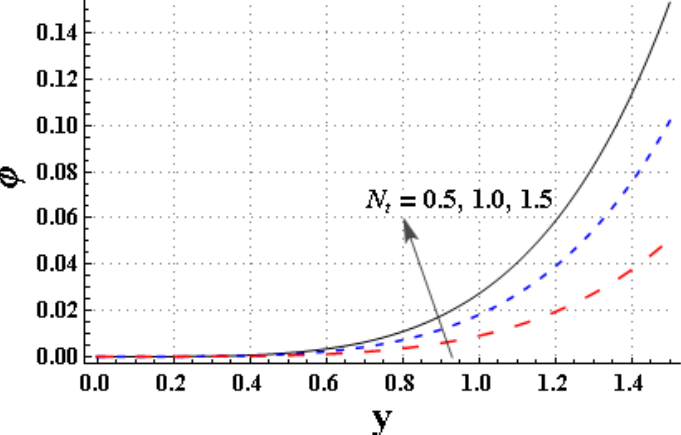
N N N , on the concentration of nanomaterials, , on the concentration of nanomaterials, , on the concentration of nanomaterials,